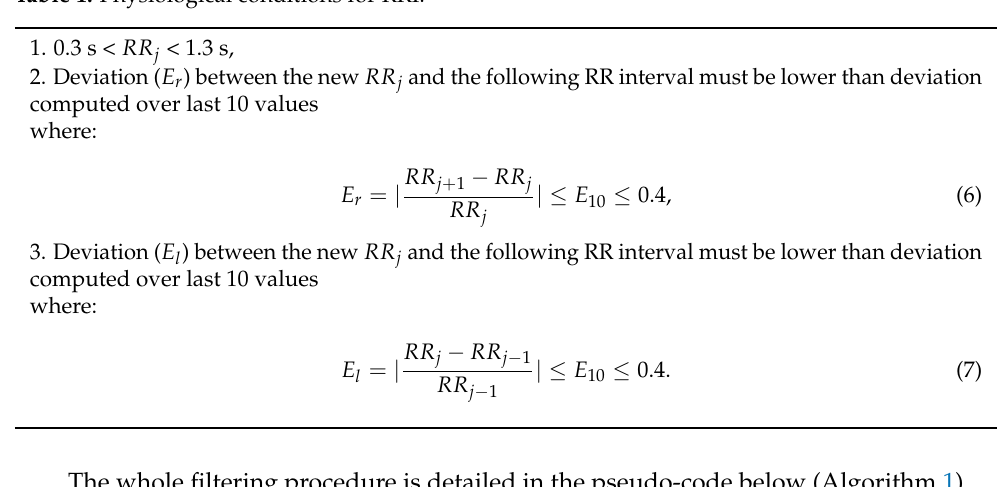
Table 1. Physiological conditions for